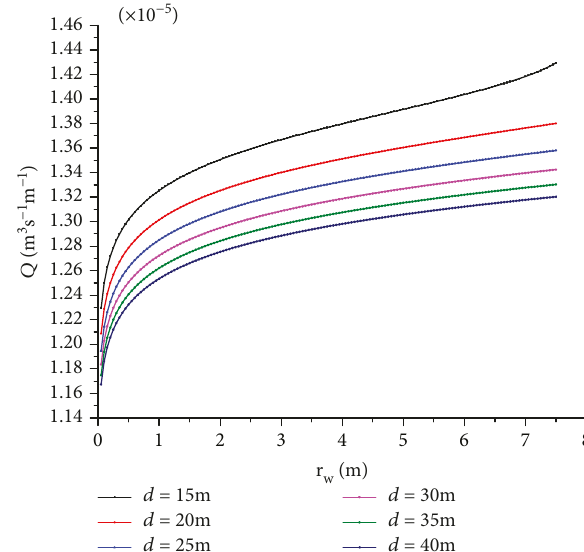
Figure 9: Relationship between the karst water fl ow and cavern